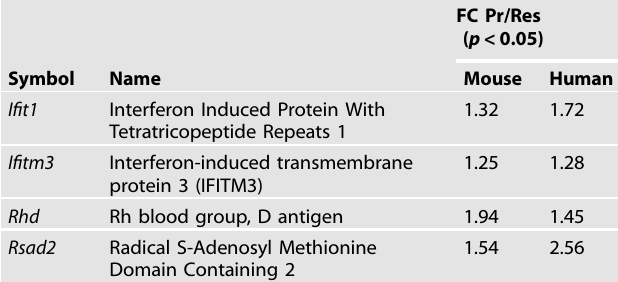
Fig. 5 Pathway nodes driving predisposition to AIWG are enriched for nodes required for body fat and postnatal weight gain in mice. In total, 699 pathway nodes included in the AIWG-P HCT intersection analysis (Supplementary fi le section 4) were plotted as log odds ratio (log OR) against log10(-log10 P). A double-log procedure was required due to the large p -value range. Nodes with signi fi cant ( q <0.05) HCT intersections with the AIWG-P gene set are colored gray with an orange border. Nodes with nonsigni fi cant ( q >0.05) intersections with the AIWG-P gene set are colored gray. A hypergeometric test was performed on the overrepresentation in the q <0.05 nodes of nodes encoded by genes in the DBFM/SPWG gene set, indicated in yellow. Refer to the Supplementary fi le for the speci fi c intersecting nodes (section 4) and the list of annotated DBFM/SPWG genes (section 5). Box acronyms: INT, intersection; OR, odds ratio; p, p -value of hypergeometric test. Translational Psychiatry (2021)